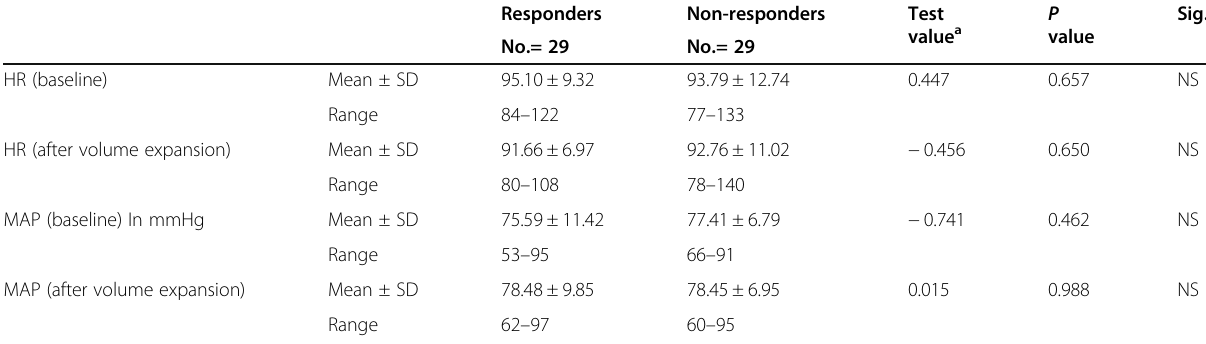
Table 2 Comparison between responders and non-responders regarding vital data of the studied patients